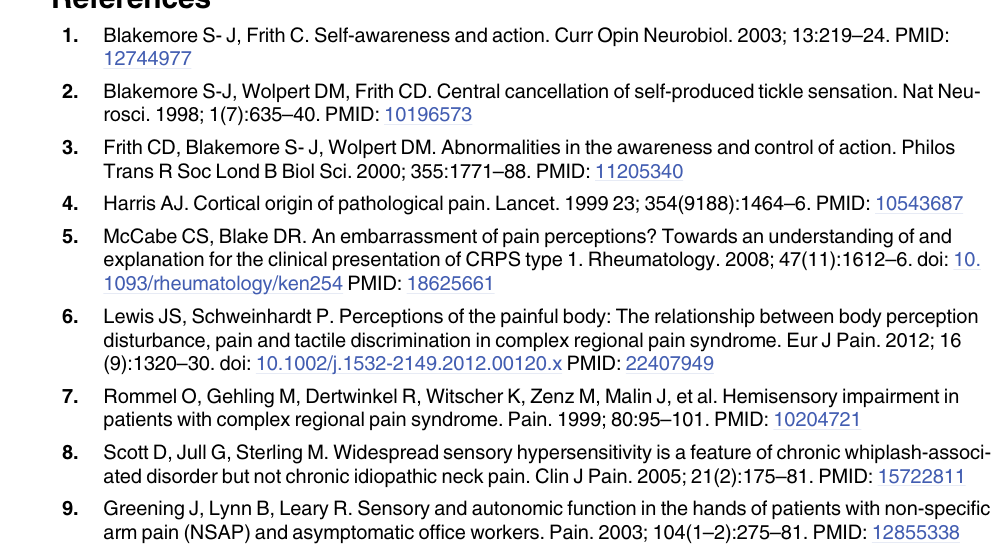
S1 Table. Individual participant